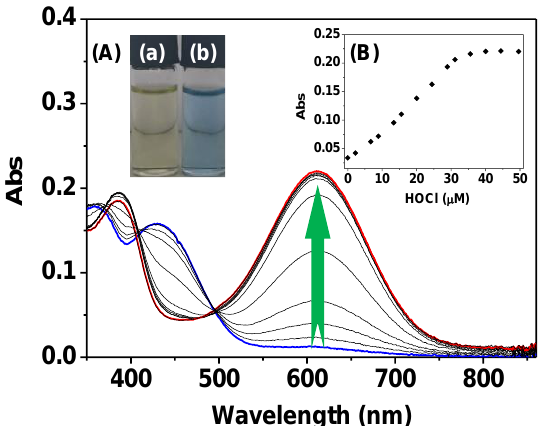
Figure 1. UV-vis absorption spectra of L-ol (10 μM) in the presence of different amounts of HOCl (0 –50 μM) in phosphate-buffered saline (PBS) aqueous buffer (dimethylformamide (DMF):PBS = 7:3, 20 mM, pH = 7.4). Inset: A. Colorimetric changes of L-ol in the (a) absence and (b) presence of HOCl; B. Plot of the absorbance at 619 nm of L-ol against the concentration of HOCl.